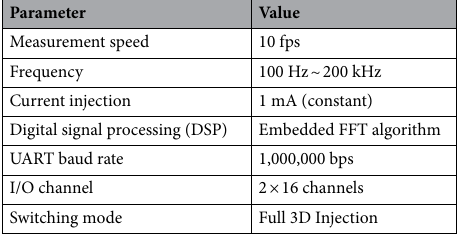
Table 2. Specification of